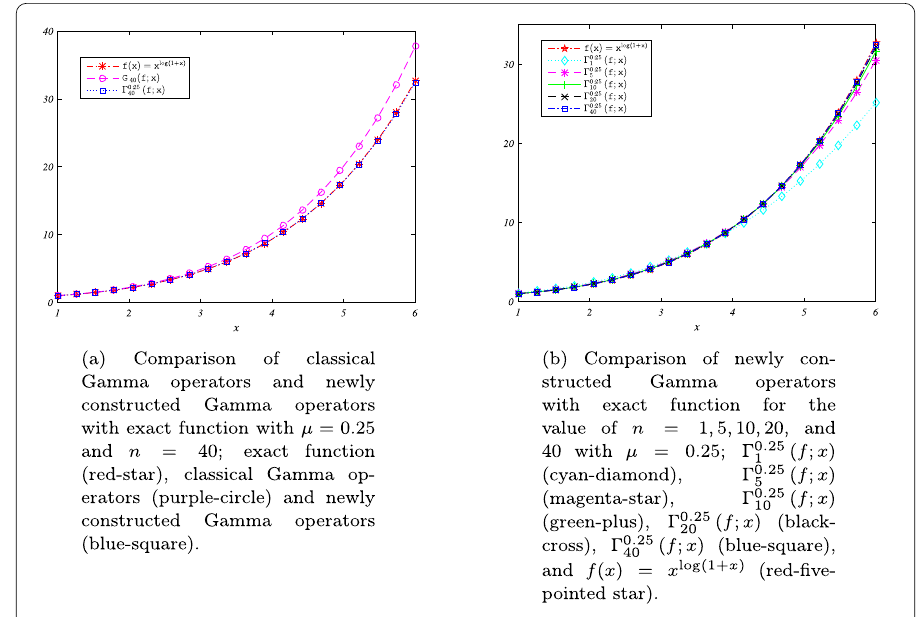
Figure 1 Approximation of target function f ( x ) on a equally spaced evaluation grid of [1,6]